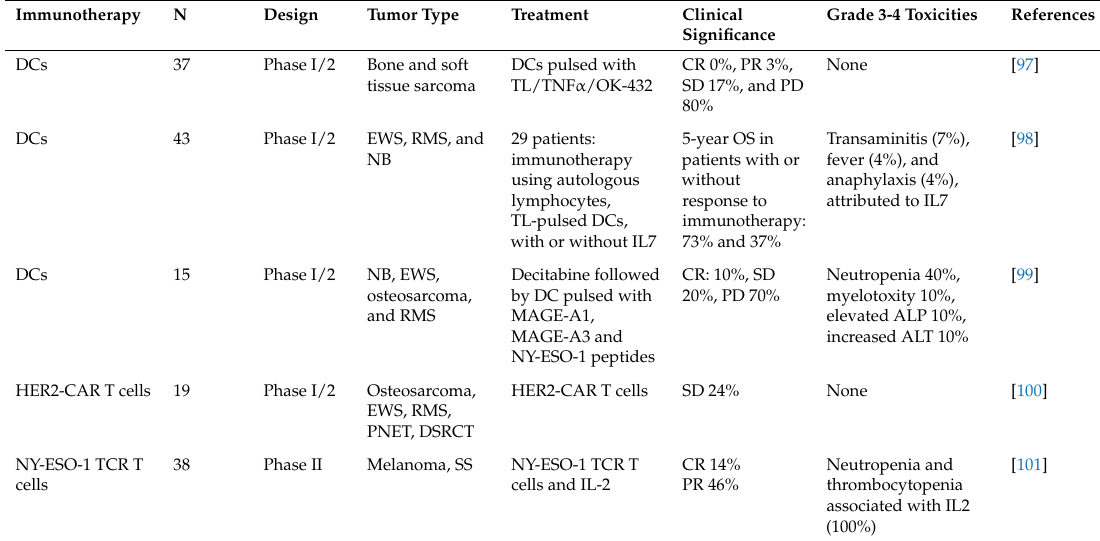
Table 3. Recent clinical studies of cellular